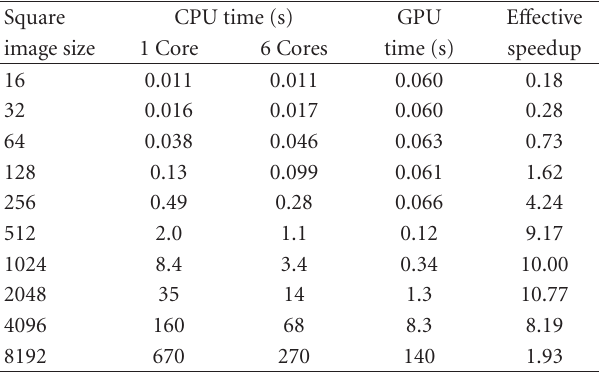
Table 2: Single-precision GPU CS MRI reconstruction times for test images ranging from 16 2 to 8192 2 with and without CPU mul- tithreading. E ff ective speedup is the multicore CPU time relative to the GPU time.